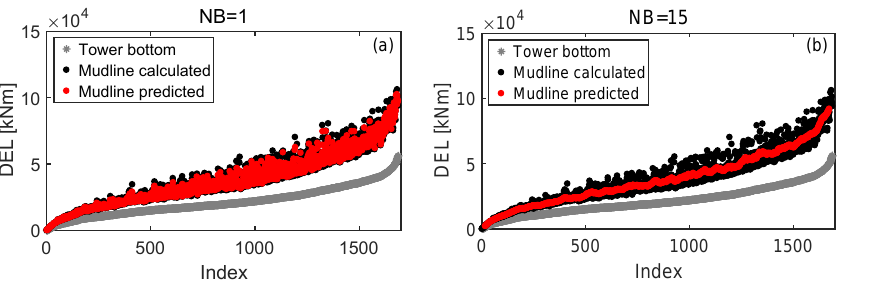
Figure 2. Simulated (black dots) and extrapolated M-DELs (red dots) considering one neighbor (a) and 15 neighbors (b) applying leave- one-out cross-validation.